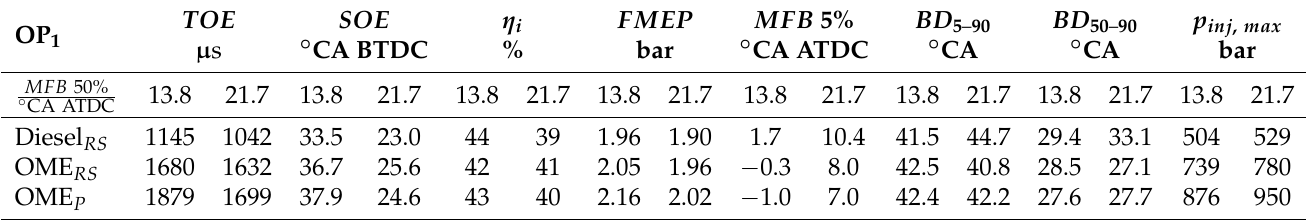
Table 5. Additional measurement values of OP 2 corresponding to Figure